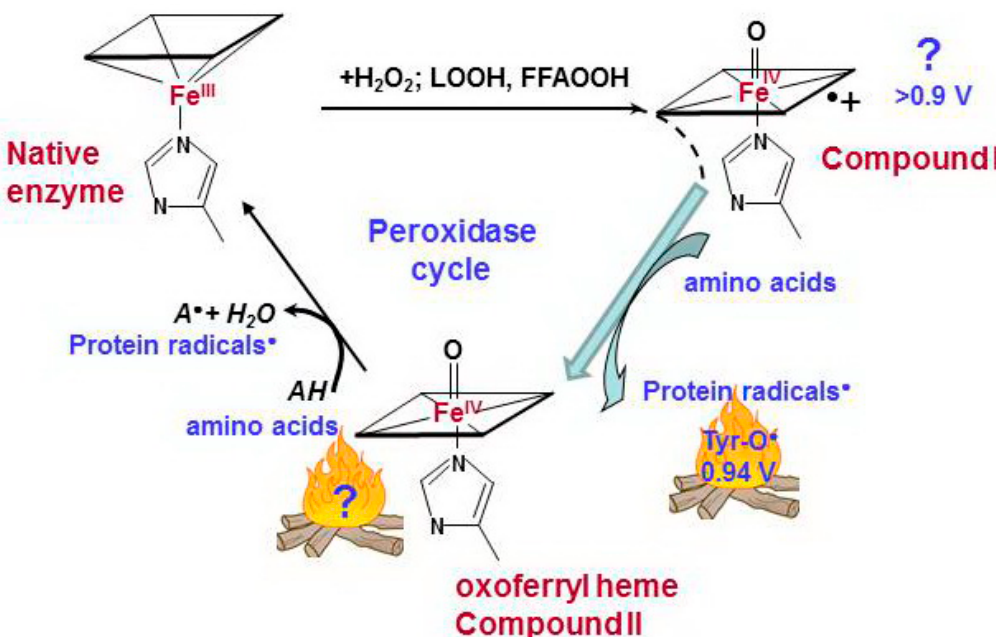
Figure 2. Catalytic cycle of pseudo-peroxidases [40,63,68,69]. The interaction between hydrogen peroxide and native ferric pseudo-peroxidase heme leads the formation of Compound I which is most likely oxoferryl porphyrin- π -cationic radical. Compound I immediately oxidizes amino acid residues (Tyr, Trp, His) which are located near the heme with formation of protein based radicals and oxoferryl heme. Oxoferryl heme iron can oxidize protein amino acids and peroxidase substrates. AH is a peroxidase substrate that is oxidized with formation of a radical (A • ). The protein-based tyrosyl radicals are the alternative reactive intermediates of pseudo-peroxidases.